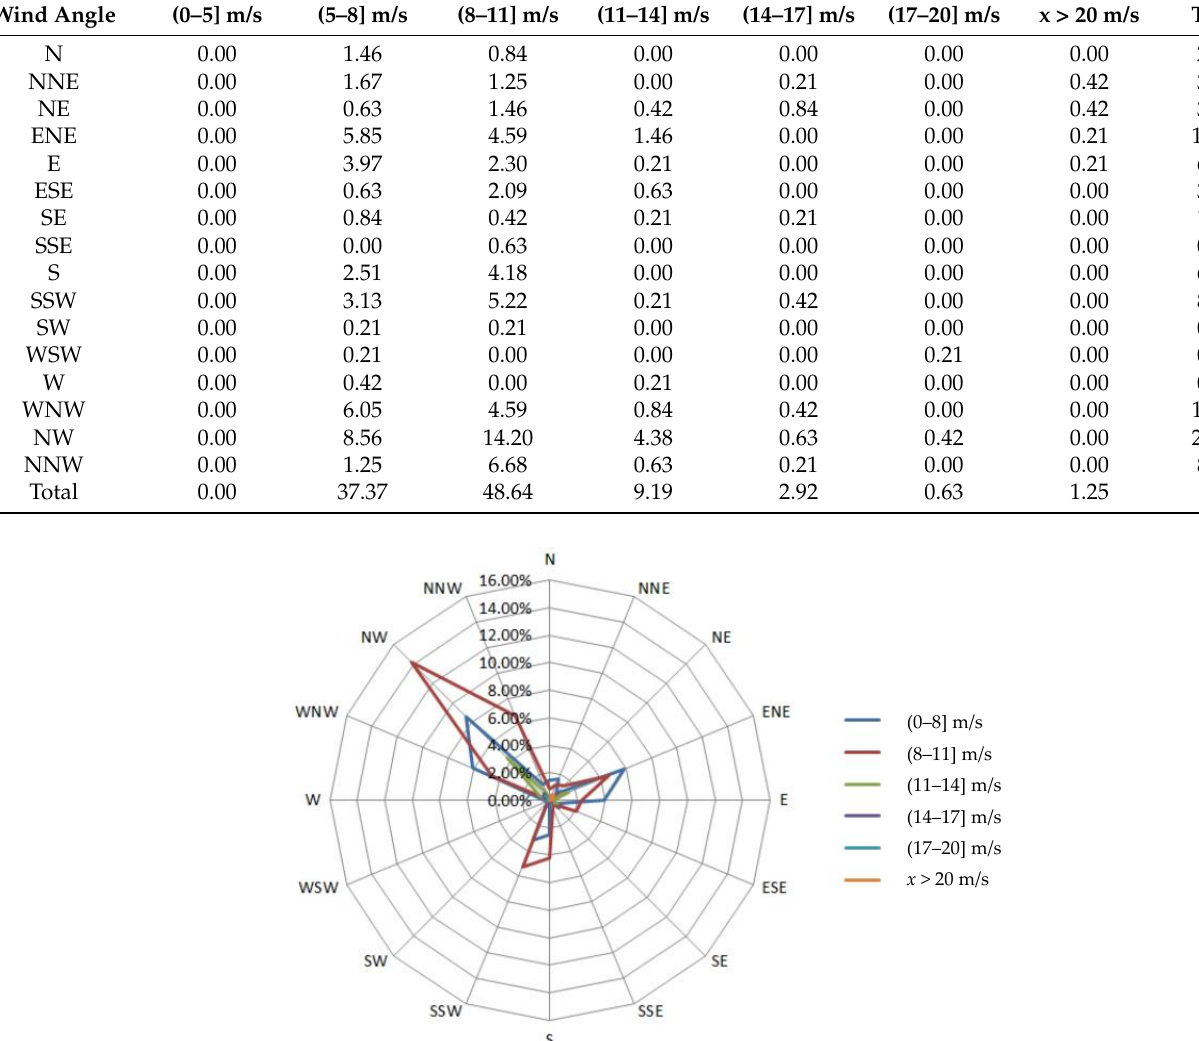
Figure 2. Monthly extreme wind rises at Hongjia station from 1978 to 2021. Table 2. The information of the M1 to M5 meteorological stations (referred as the five main sta- tions).